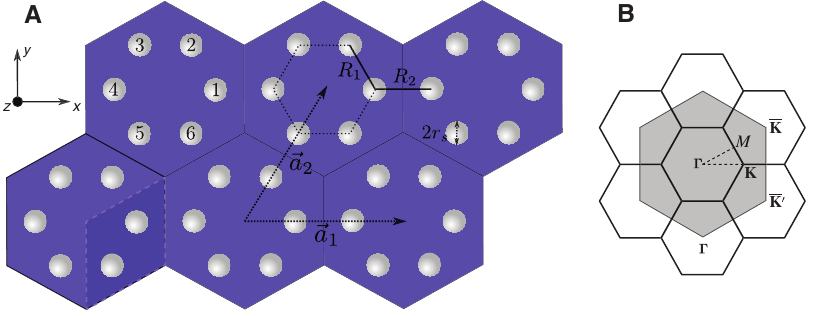
Figure 1: The plasmonic nanoparticle array in real and reciprocal space. (A) The proposed plasmonic nanosphere array. The primitive lattice is a triangular lattice with basis vectors cell has six nanospheres (labeled from 1 to 6) arranged in a hexagonal cluster (called a meta-molecule ). (B) The Brillouin zone corresponding to the rhombic unit cell of a perfect honeycomb lattice [highlighted at the left bottom of ( a )], shown as a gray area, compared to the smaller Brillouin zone corresponding to the hexagonal unit cell adopted in this